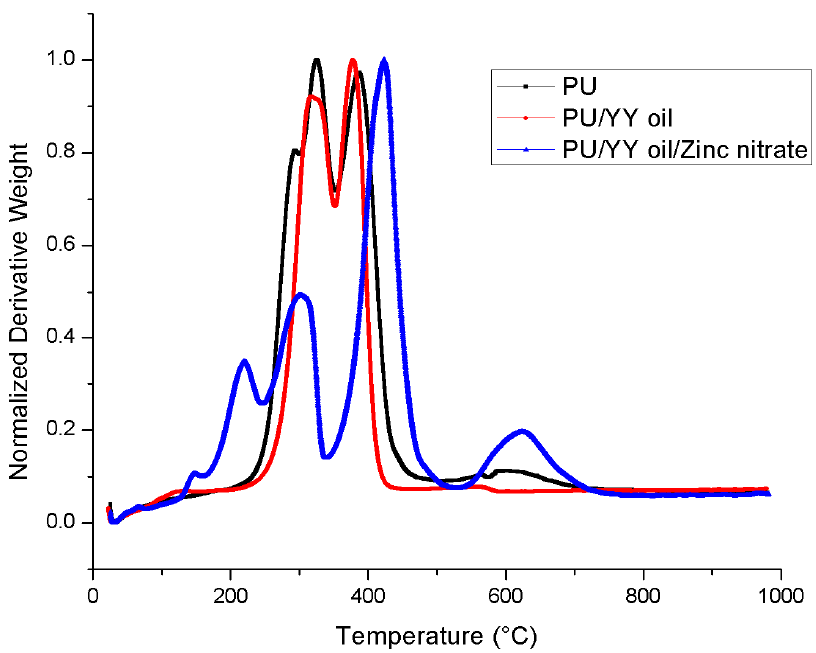
Figure 6. Weight residue of PU, PU/YY and PU/YY/ZnNO 3. Table 1. Weight loss peaks of the electrospun membranes.